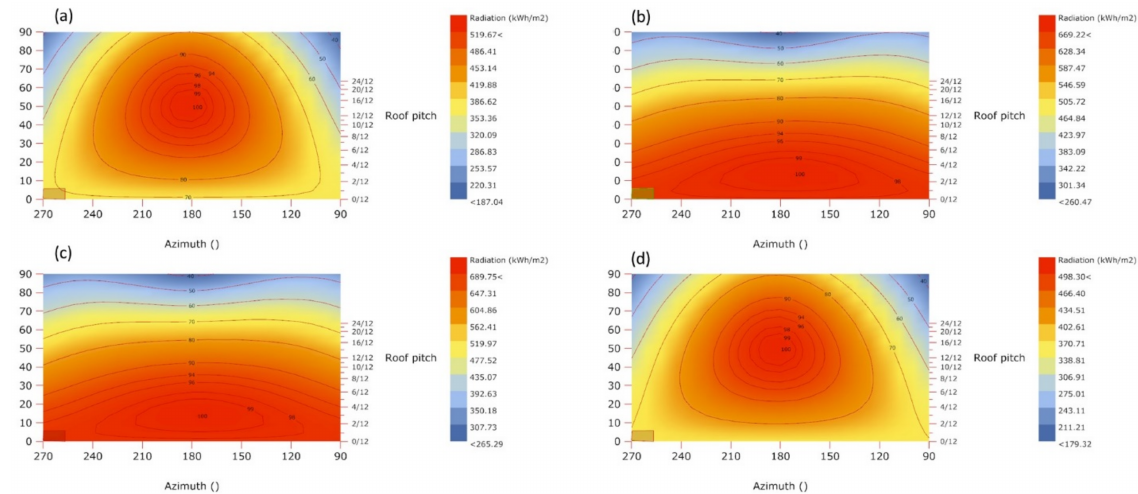
Figure 6. The intensity of solar radiation depending on the Photovoltaic panel tilt angle in each season: ( a ) optimal tilt 49.5 receiving 519 kWh/m 2 during winter; ( b ) optimal tilt 13.5 receiving 669.22 kWh/m 2 during spring; ( c ) optimal tilt 13.5